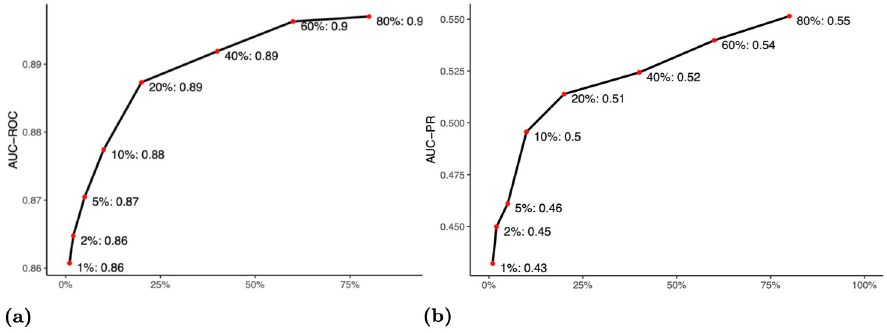
Fig 3. AUC for (a) ROC and (b) PR on testing data for RF with top 250 tokens with proportion of pre-labeled documents ranging from 1% to